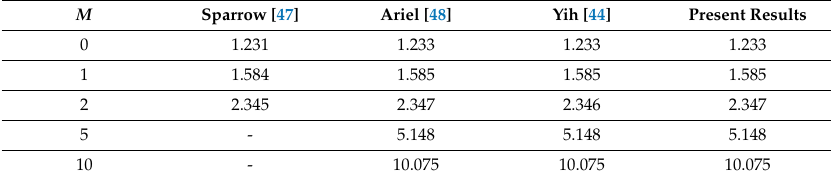
Table 1. Comparison of results of skin friction when Da → ∞ , λ = Ω = 0, K = Pr = 1. M